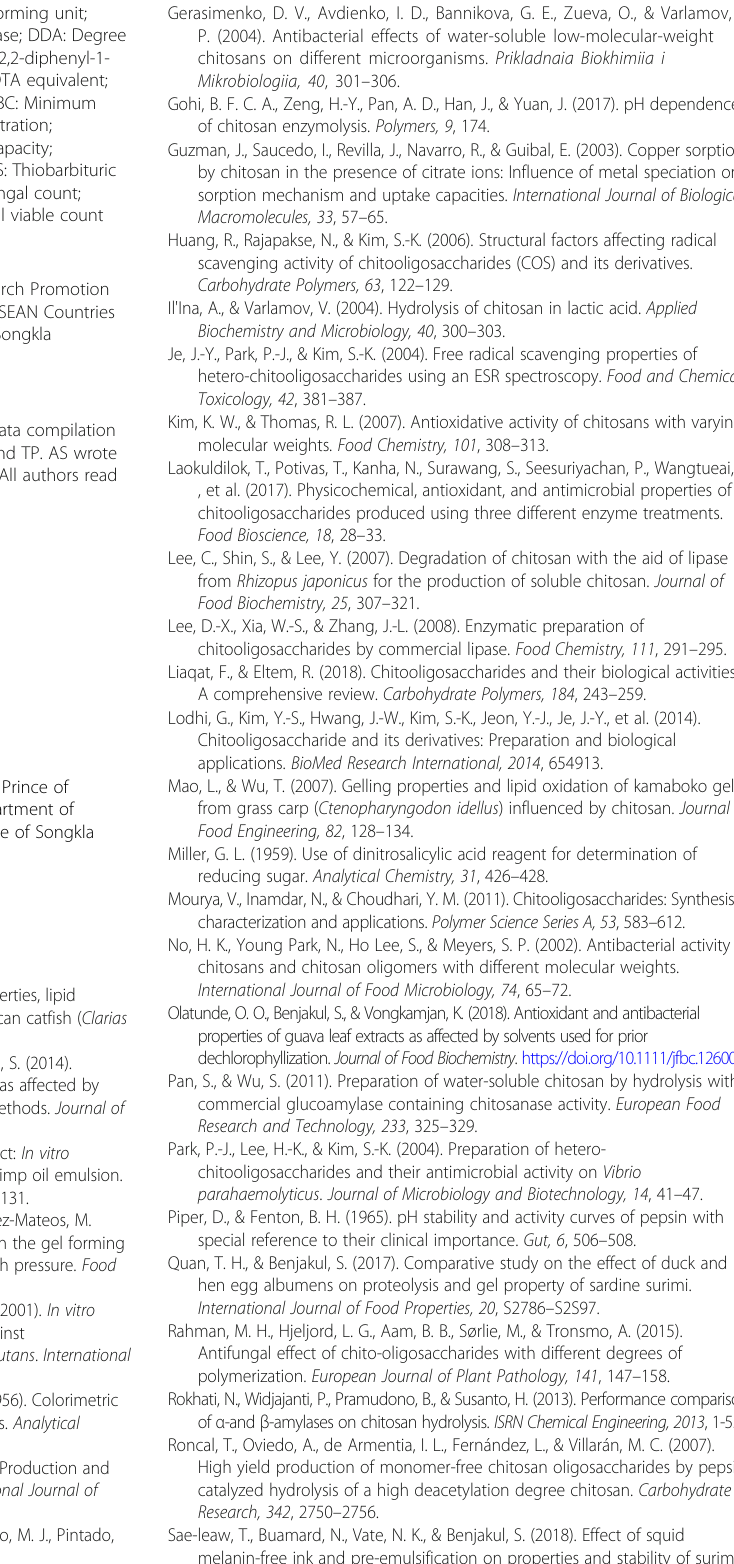
Abbreviations AAPH: 2,2 ′ -azobis (2-methylpropionamidine) dihydrochloride; ABTS: